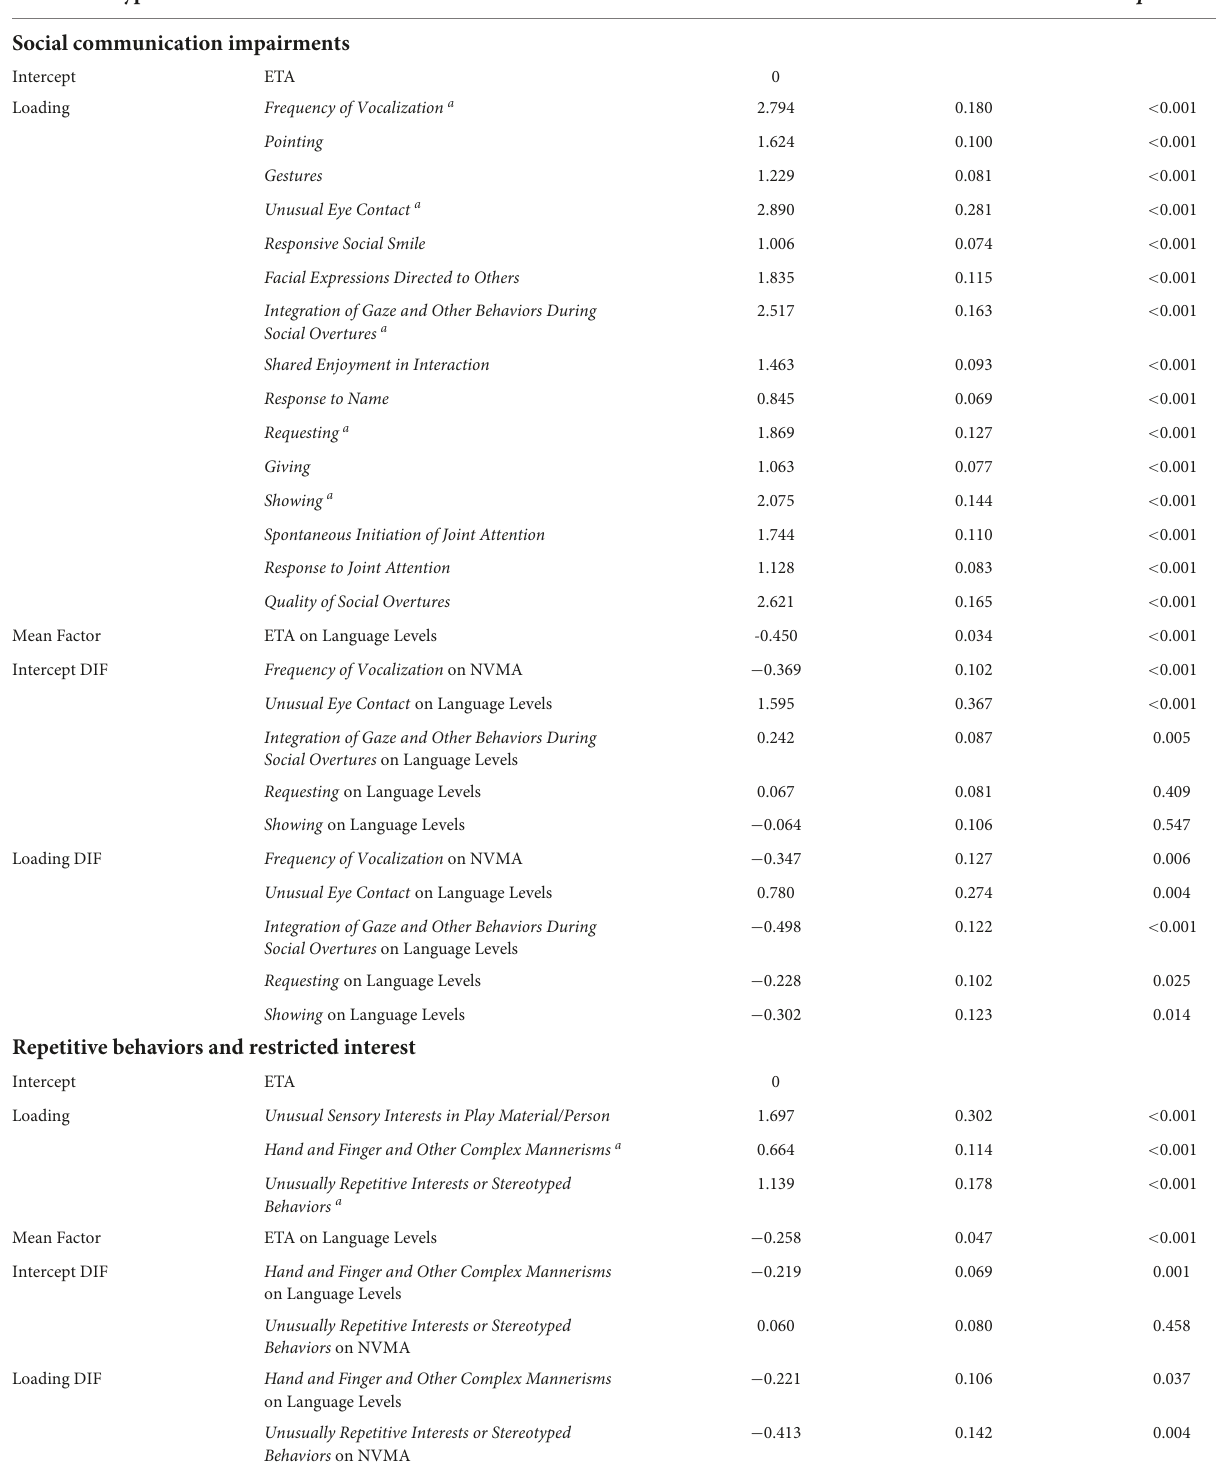
TABLE 5 Parameter estimates of the resulting MNLFA